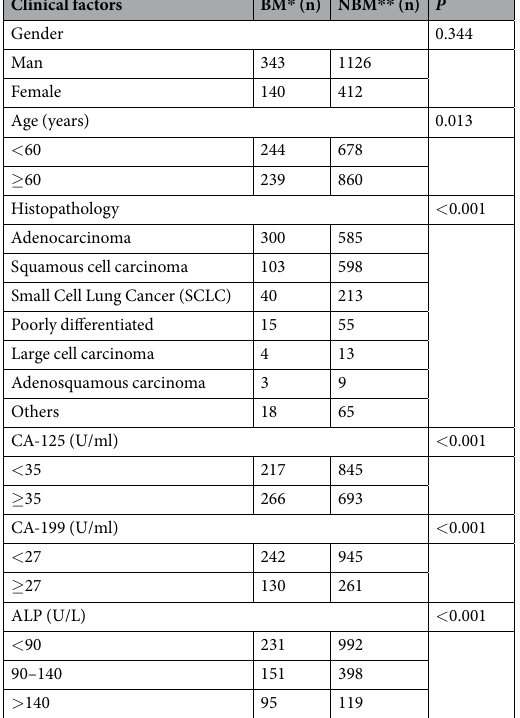
Table 2. The differences between patients with and without bone metastases. * BM: bone metastases group; ** NBM: non bone metastases group.